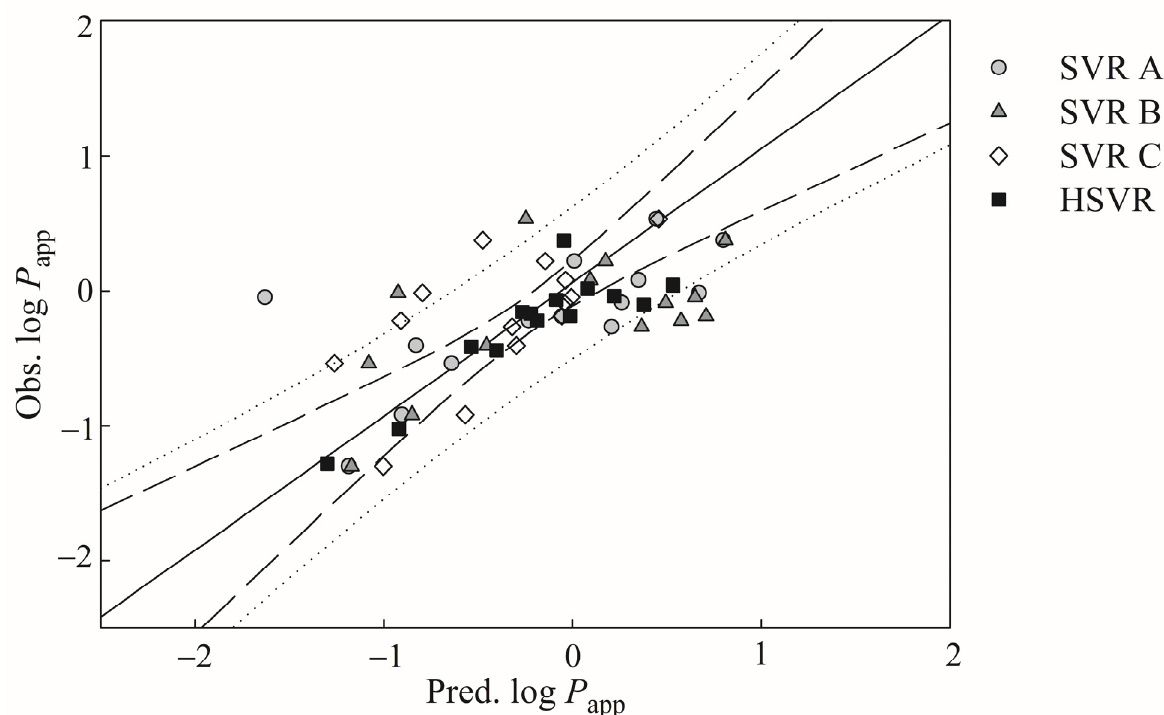
Figure 4. Observed log P app versus the log P app predicted by SVR A (gray circle), SVR B (gray triangle), SVR C (open diamond), and HSVR (solid square) for the outlier samples. The solid, dashed, and dotted lines represent the HSVR regression of the data, 95% confidence intervals for the HSVR regression, and 95% confidence intervals for the prediction, respectively.